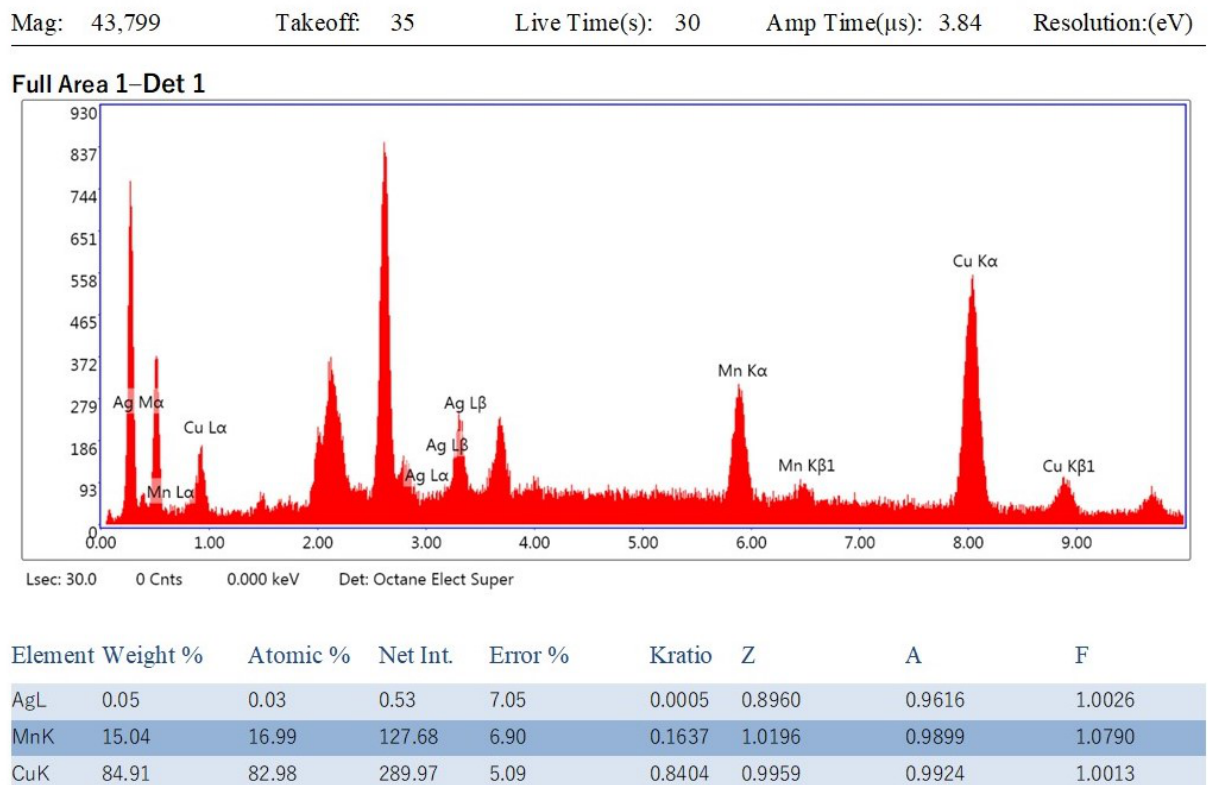
Figure 4. EDX spectra and elemental composition of biosynthesized Cu-Mn bimetallic nanoparticles.